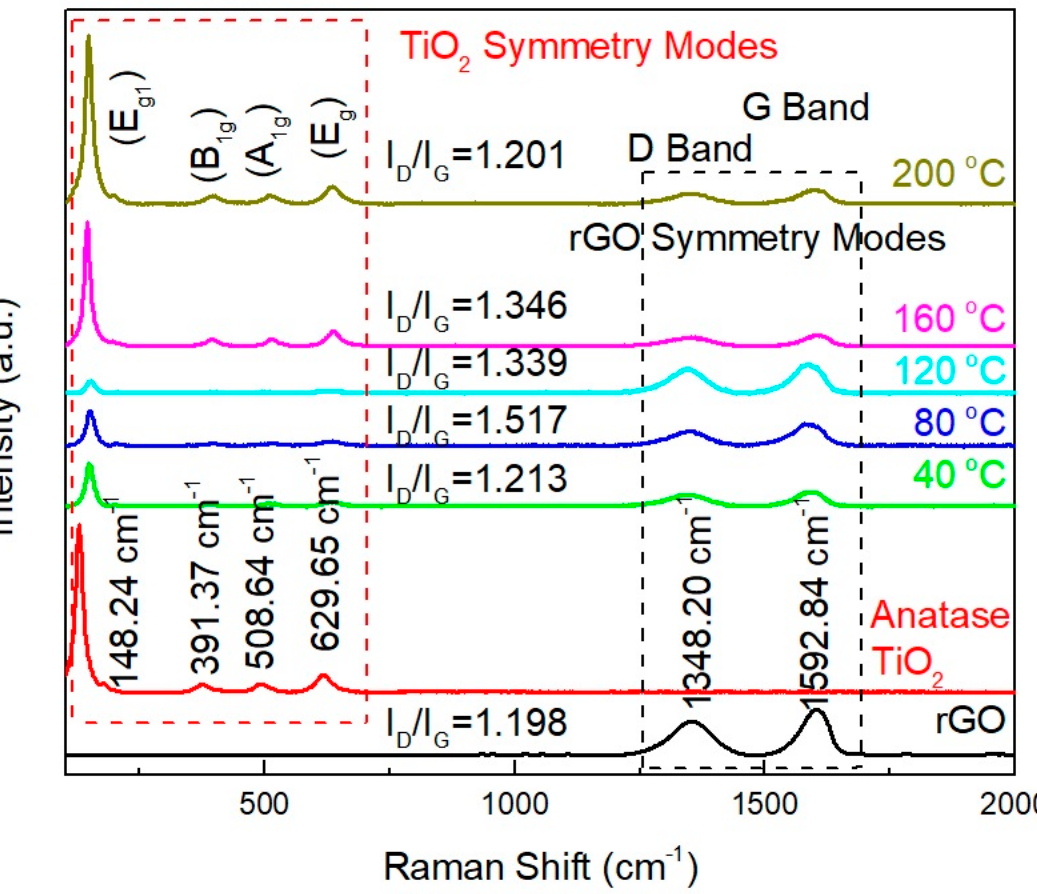
Figure 10. Raman spectra of rGO, anatase TiO 2 , and rGO-TiO 2 nanocomposites based on different sputtered temperatures from 40 to 200 °C.